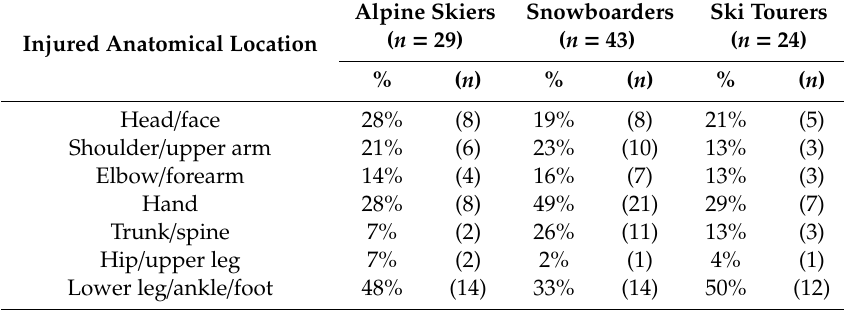
Table 4. Frequencies of injured anatomical locations separately for alpine skiers, snowboarders, and ski tourers (participants with treated injuries only).